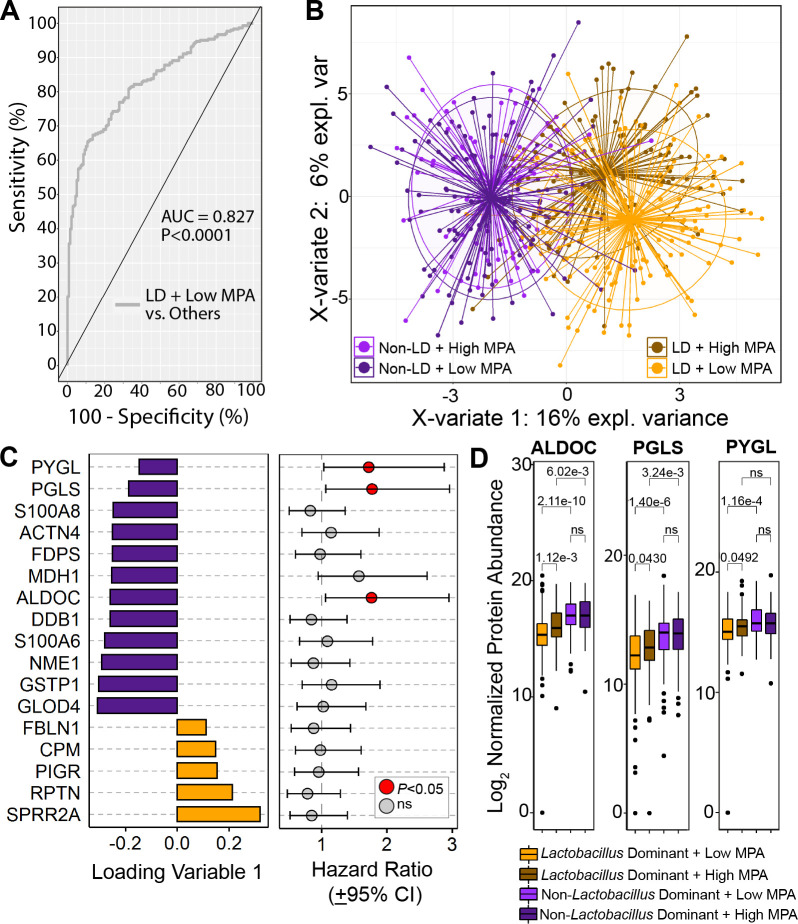
Cervicovaginal protein signatures associated with MPA levels of women with vaginal Lactobacillus dominance.A LASSO algorithm identified 17 proteins that best classified LD women with low MPA levels from LD women with high MPA levels, as well as all non-LD women. (A) An area under the curve (AUC) plot shows the protein signature was accurately able to classify women with an LD vaginal microbiome and low serum MPA from other groups (AUC = 0.827, P<0.0001). (B) A PLSDA plot shows LD/low MPA women separated from other groups along X-variates 1 and 2. (C) A loadings plot shows protein contributions to the identified signature. Orange bars indicate proteins increased in the LD/low MPA group, while purple bars indicate those increased in all other groups. Box and whisker plots display the hazard ratios (HR) estimated from cox proportional hazards models between MPA-associated glucose metabolism biomarker levels and HIV acquisition risk across all women in the study (n = 685). (D) MPA-risk biomarker expression in microbiome-MPA groupings. LASSO = Least Absolute Shrinkage and Selection Operator, PLSDA = Partial Least Squares Discriminant Analysis, MPA = Medroxyprogesterone acetate, LD = Lactobacillus dominant, non-LD = Non-Lactobacillus dominant, HR = hazard ratio, CI = 95% confidence interval.